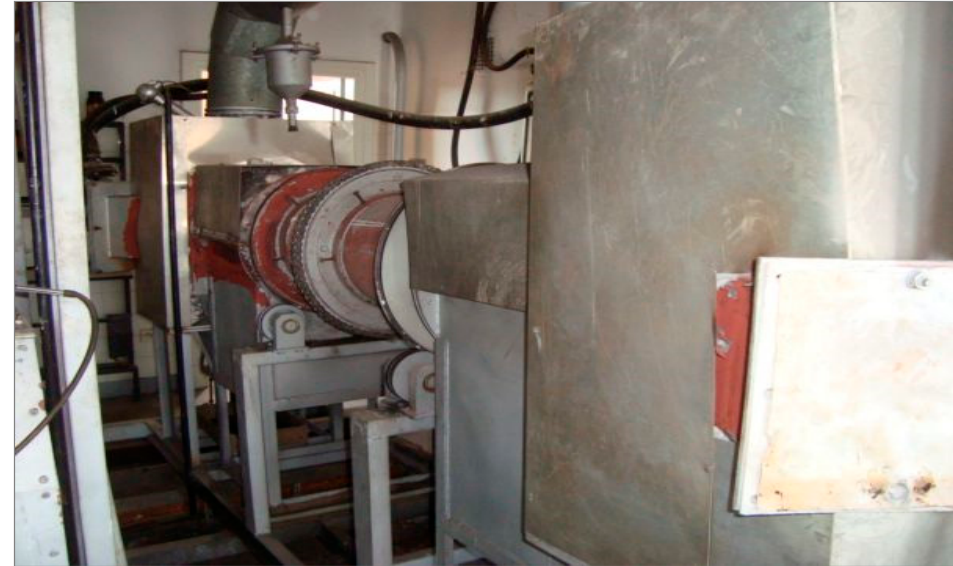
Figure 8. View of the laboratory rotary kiln.